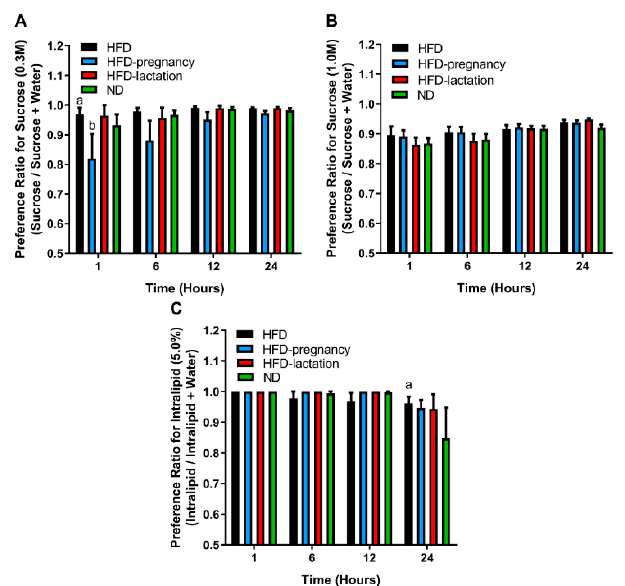
Figure 5. Long access two-bottle preference tests. Two-bottle preference tests for 0.3 M ( A ) and 1.0 M ( B ) sucrose and 5.0% Intralipid ( C ). Group representations are as follows for all three graphs: black columns: HFD offspring ( n = 9); light blue columns: HFD-pregnancy offspring ( n = 9); red columns: HFD-lactation offspring ( n = 7); and green columns: ND group of offspring ( n = 9). Statistical symbols (a,b) represent post hoc comparisons between groups. In the case of 0.3 M sucrose ( A ) a: p < 0.01 compared with HFD-pregnancy; b: p < 0.05 compared with HFD-lactation. In the case of 5.0% Intralipid ( C ) a: p < 0.01 compared with ND. Data expressed as mean ± SEM. For more details and statistics, see Results.